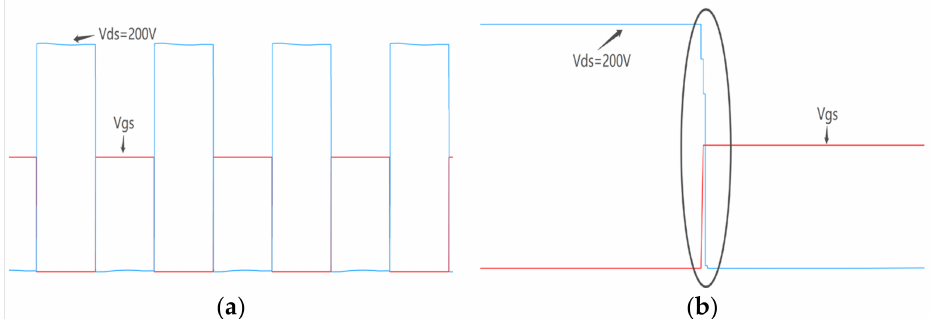
Figure 6. Simulation results for f s = 100 kHz: ( a ) Steady-state waveforms (time scale: 4 µ s/div); ( b ) partial amplification waveforms (time scale: 800 ns/div).